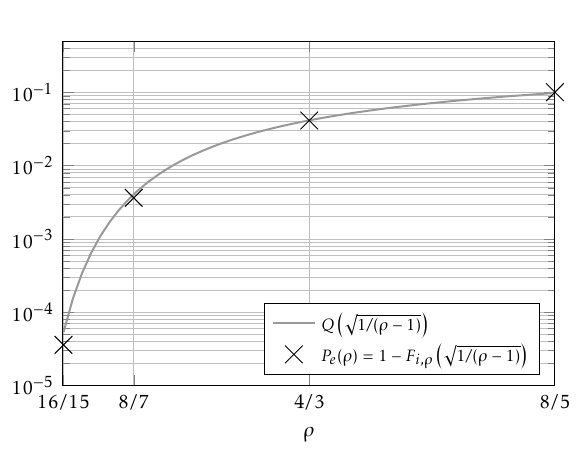
Figure 3. Comparisonof the real CCDF of the interference varyingon ρ and its Gaussian approximation.